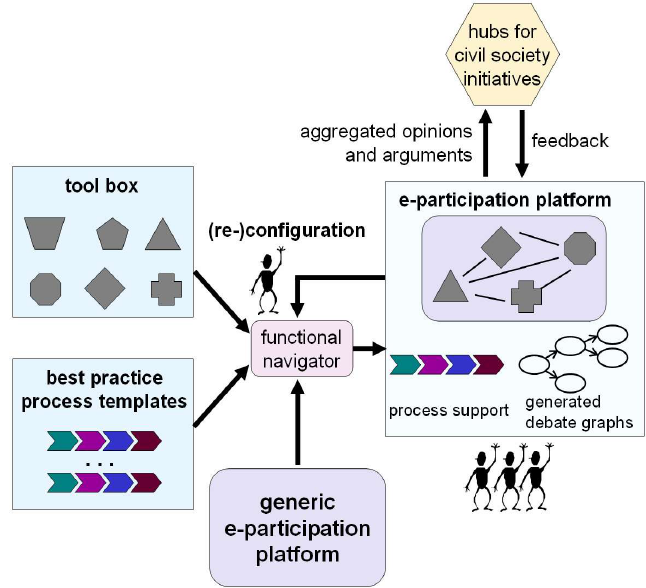
Figure 1: Overview of planned